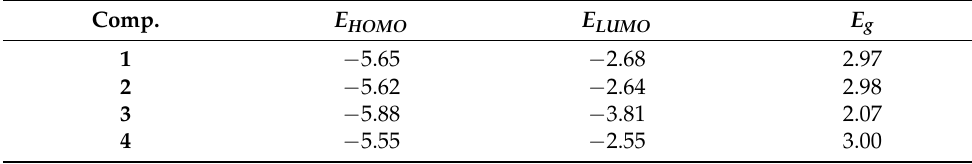
Table 1. The LUMO energies ( E LUMO ), HOMO energies ( E HOMO ), and energy gaps ( E gap ) (in eV) of Schiff base compounds at B3LYP/6-31+G** level.